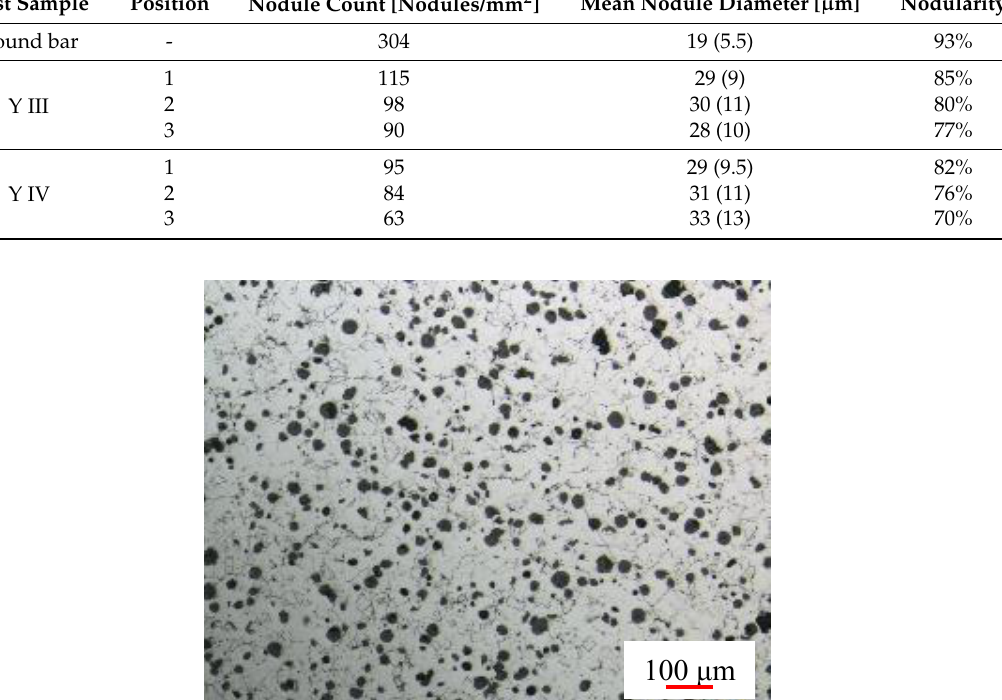
Figure 9. Micrographs of specimens taken from type III cast sample, position 1 ( a ), 2 ( b ) and 3 ( c ) and type IV cast sample, position 1 ( d ), 2 ( e ) and 3 ( f ).